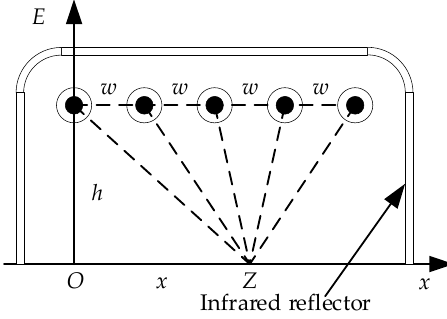
Figure 6. Irradiance of infrared thermal excitation device.